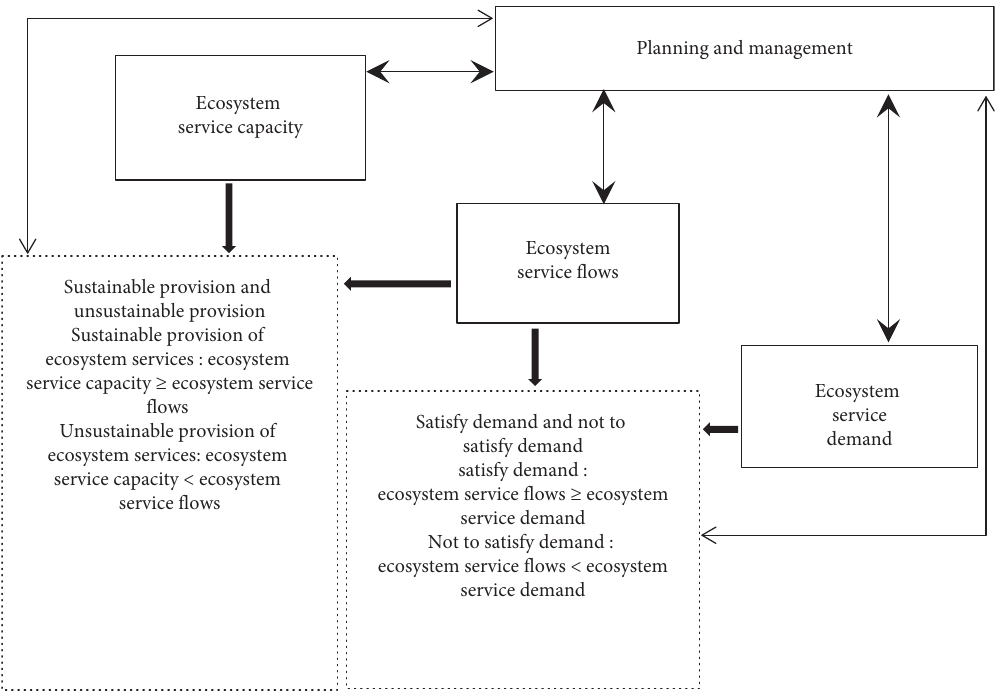
Figure 1: Flow chart of relationships among ecosystem service capacity, traffic, demand, and planning